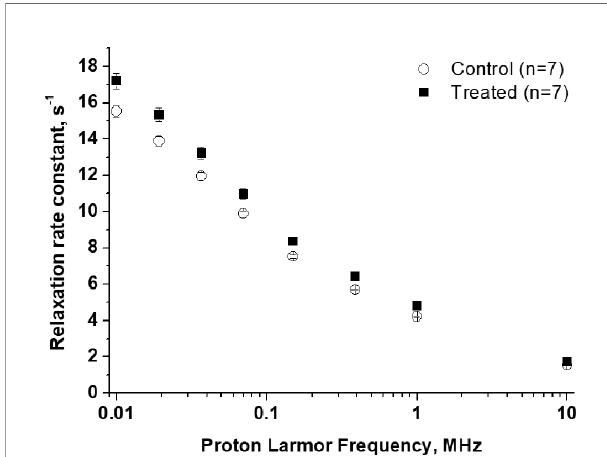
FIGURE 4 | 1/T 1 1 H-NMRD pro fi les of tumor-bearing mouse legs: treated animals (n=7), black square, compared to control animals (n=7), empty circle. Error bars represent the SE of the experimental data. (p value at 0.01 MHz =